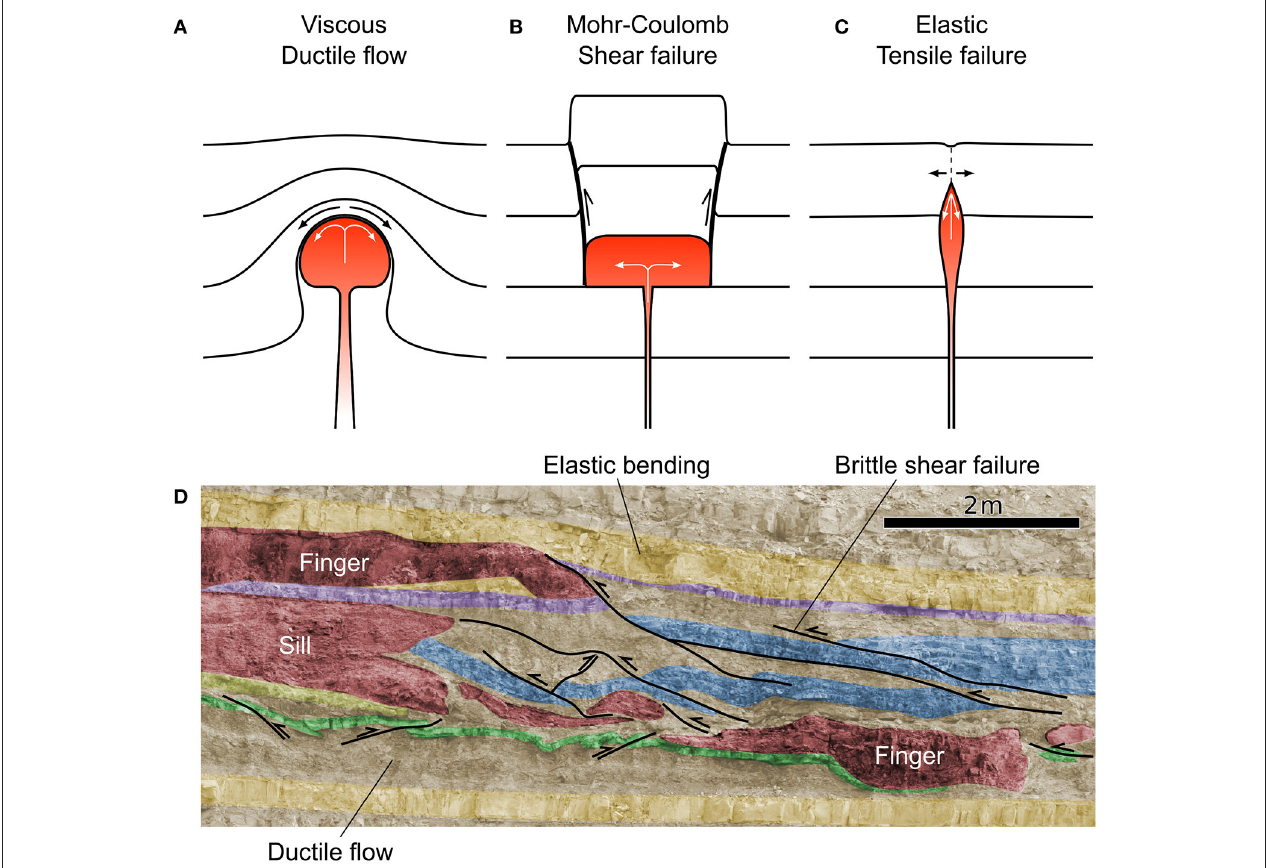
FIGURE 1 | Diagram of idealized end-member cases of magma ascent. (A) A diapir (viscous end-member) indents and displaces the surrounding host rock extensively, making the host rock viscosity a fundamental parameter for governing ascent rate. (B) A punched laccolith (brittle shear failure end-member) indents and displaces the overburden, which fails along plastic, brittle faults. (C) A dyke (elastic end-member) fractures and intrudes the host rock with negligible host rock displacement, thus, the ascent rate is primarily controlled by host rock fracture strength and magma viscosity. Adapted from Rubin (1993). (D) Interpreted field photograph of outcrop exposing a sheet-like sill, magmatic fingers, and the associated structures in the shale-carbonate host rock, Cuesta del Chihuido, Mendoza Province, Argentina (Spacapan et al., 2017). The outcrop shows that the sill tip is round or blunt, and that both ductile deformation of the shale layers, brittle shear faulting of thin carbonate layers and elastic bending of thick carbonate layers accommodate the emplacement and propagation of the sill. Detailed descriptions of the structures and associated mechanisms can be found in Spacapan et al.